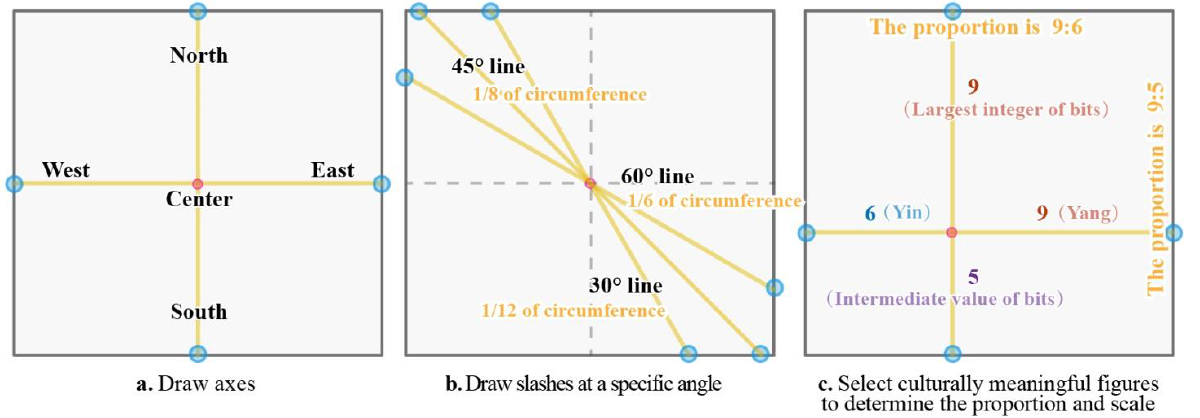
Figure 5. Schematic diagram of the graphic operation method.